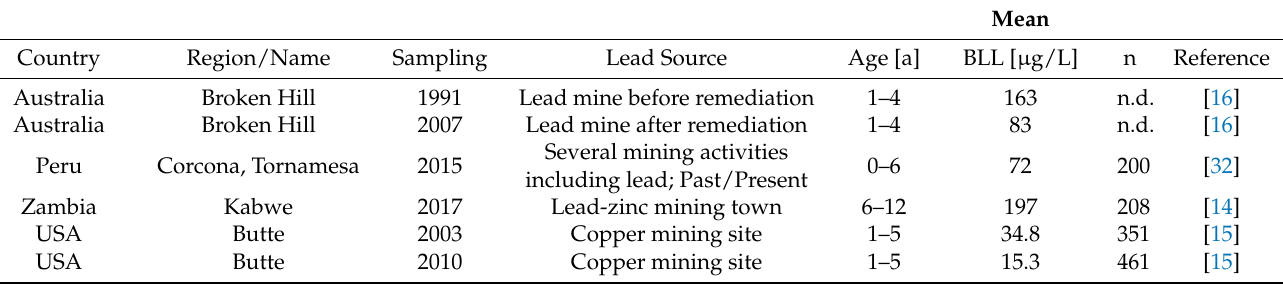
Table 3. Comparison of our study to similar studies for children and